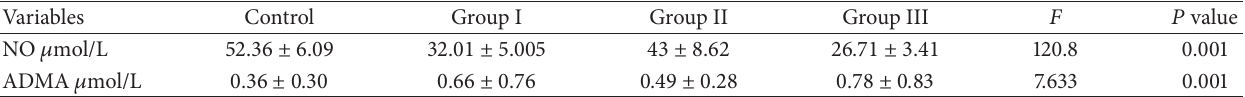
Table 2: Risk factors.